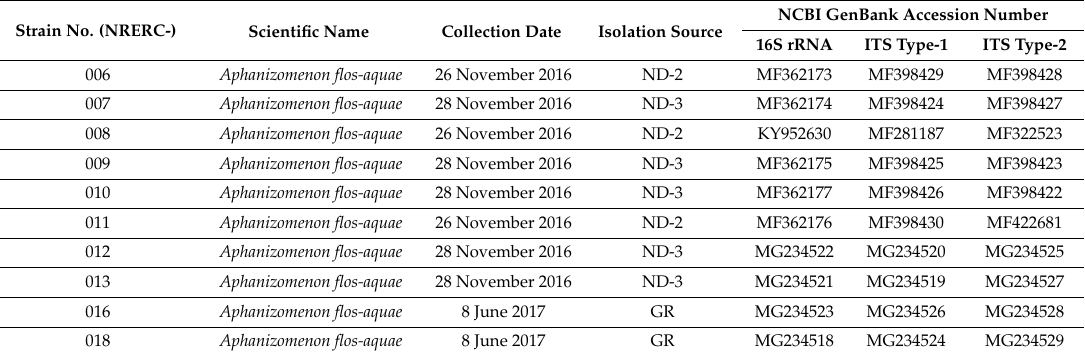
Table 2. Information for Aphanizomenon flos-aquae strains isolated from the Nakdong River and NCBI GenBank Accession Numbers of the 16S rRNA and 16S-23S rRNA ITS sequences of each strain. Strain No.